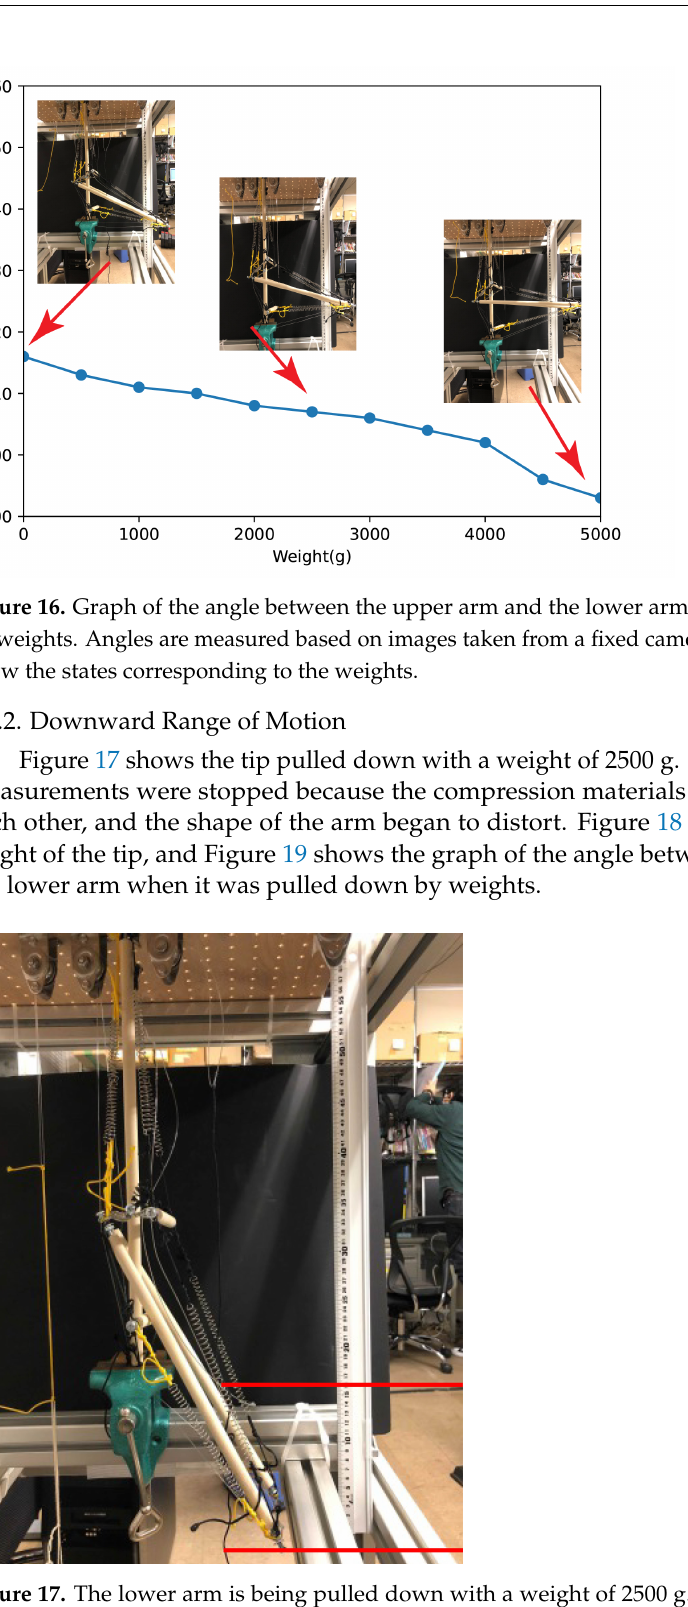
Figure 17. The lower arm is being pulled down with a weight of 2500 g. The upper red line is the initial height of the tip shown in Figure 10. The lower red line is the height of the tip. The tip appears lower than its actual height due to the angle of the camera. The tip of the arm is pulled by a weight through the path of the pulley string shown in Figure